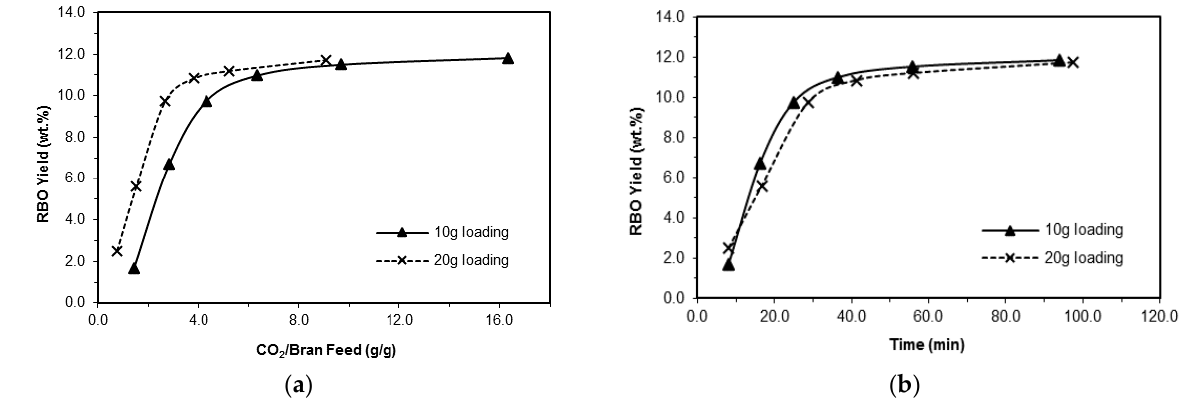
Figure 1. Supercritical fluid extraction yield of rice bran oil as a function of ( a ) consumed CO 2 and ( b ) time using 10 g and 20 g of rice bran loading (at 40 MPa, 313 K, and CO 2 flow rate of 1 L/min).